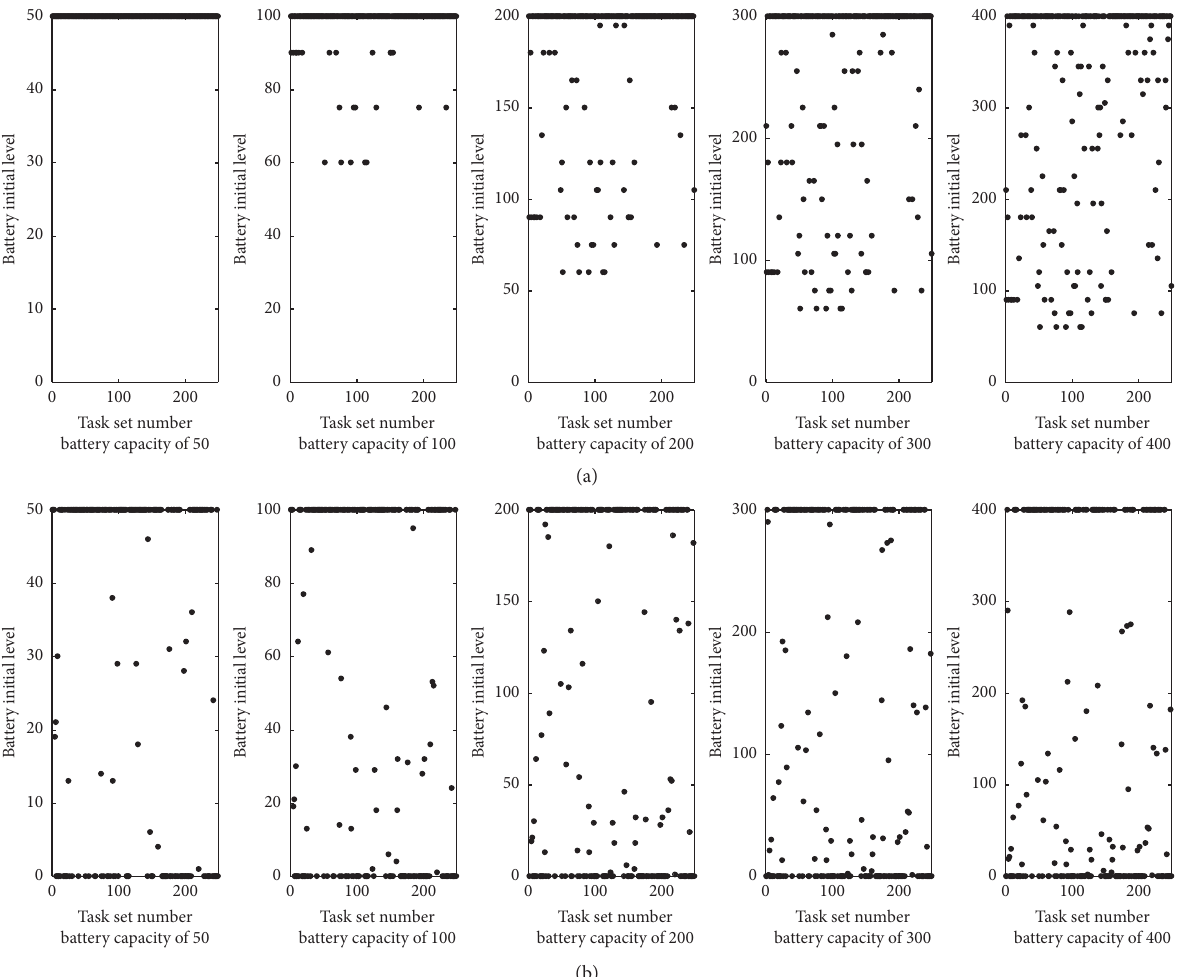
Figure 5: The ALAP scheduling algorithm calculating the initial battery level based on the WCRT-IELB and AC-IELB algorithms. (a) WCRT-IELB algorithm. (b) AC-IELB